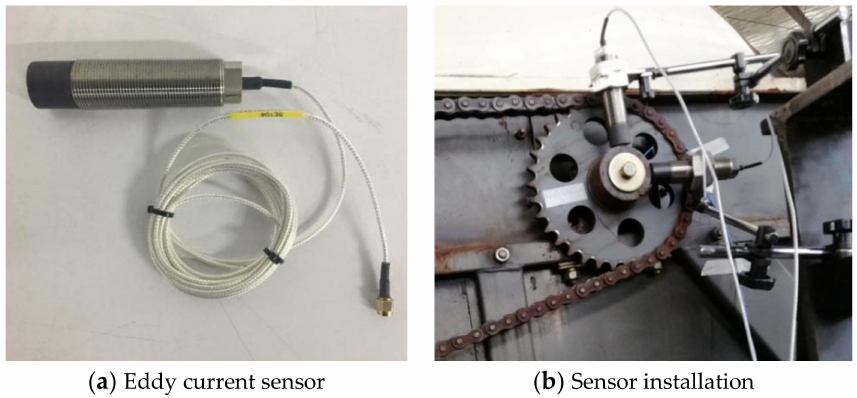
Figure 7. Axis center trajectory test method and sensors.